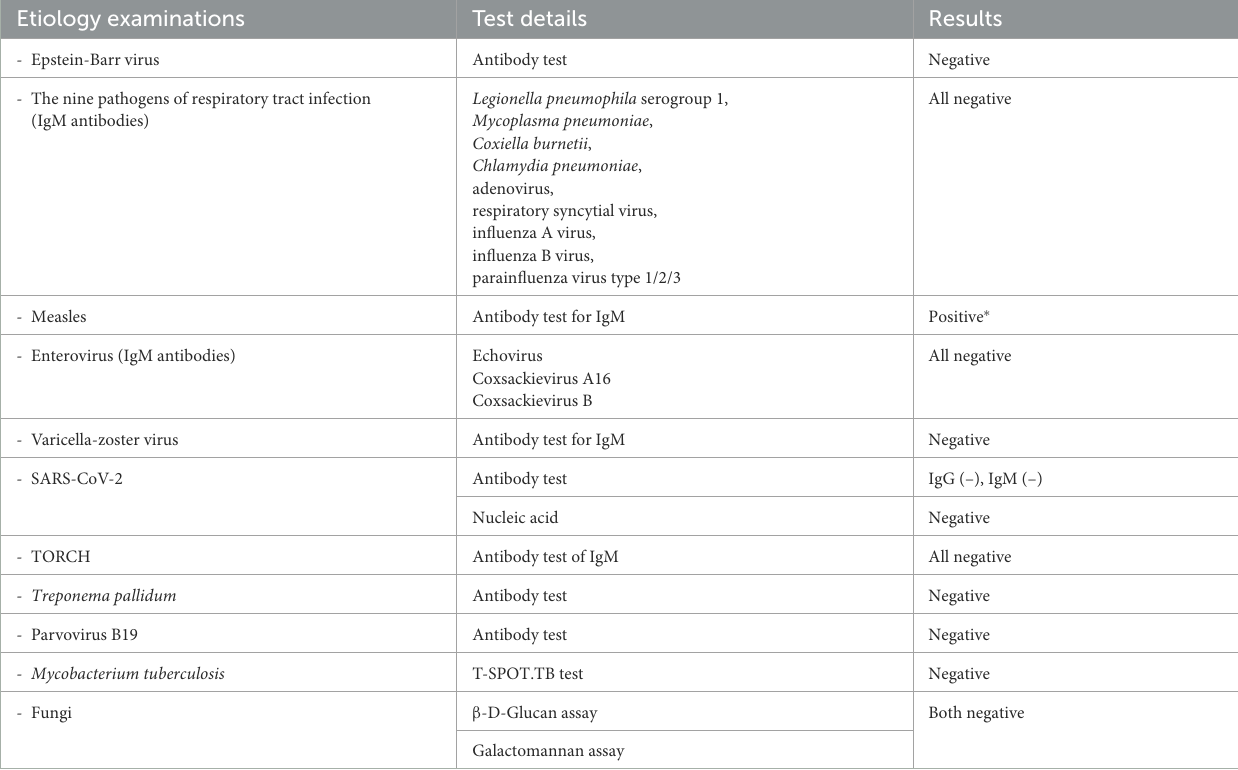
TABLE 1 Etiology examinations of the patient.